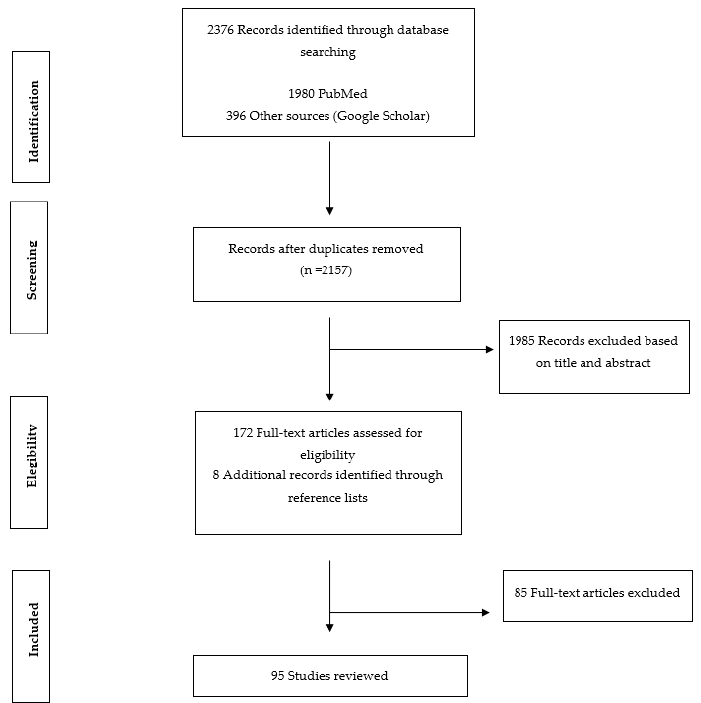
Figure 1. Flowchart for inclusion of studies.